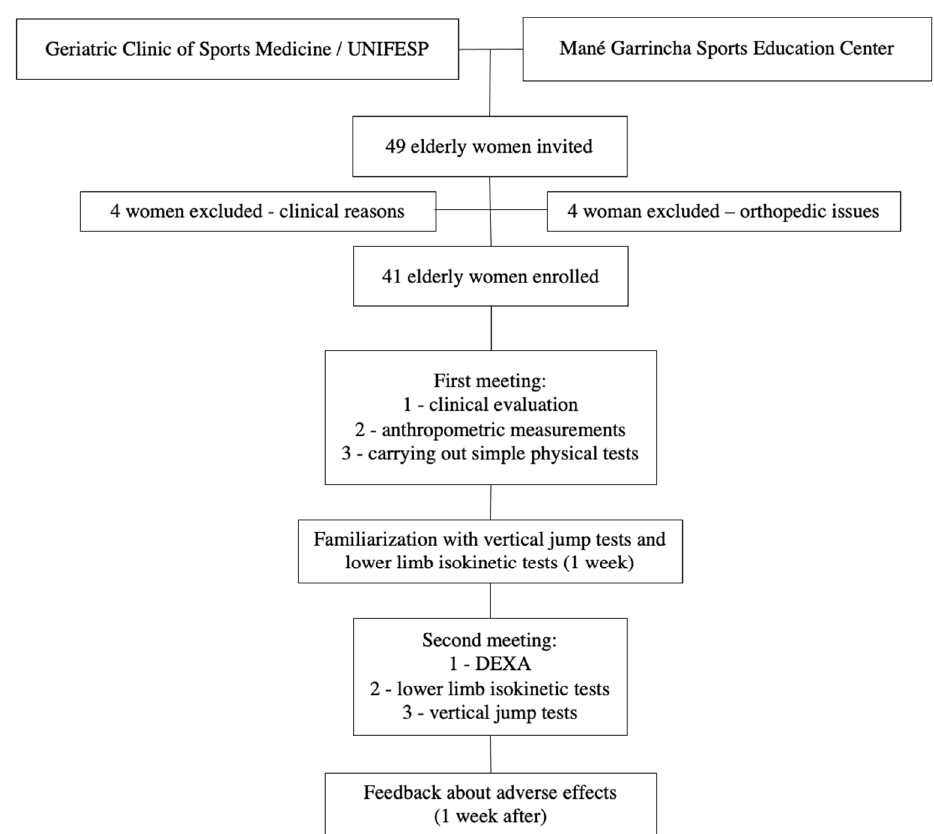
Figure 1. Flow diagram and study design.